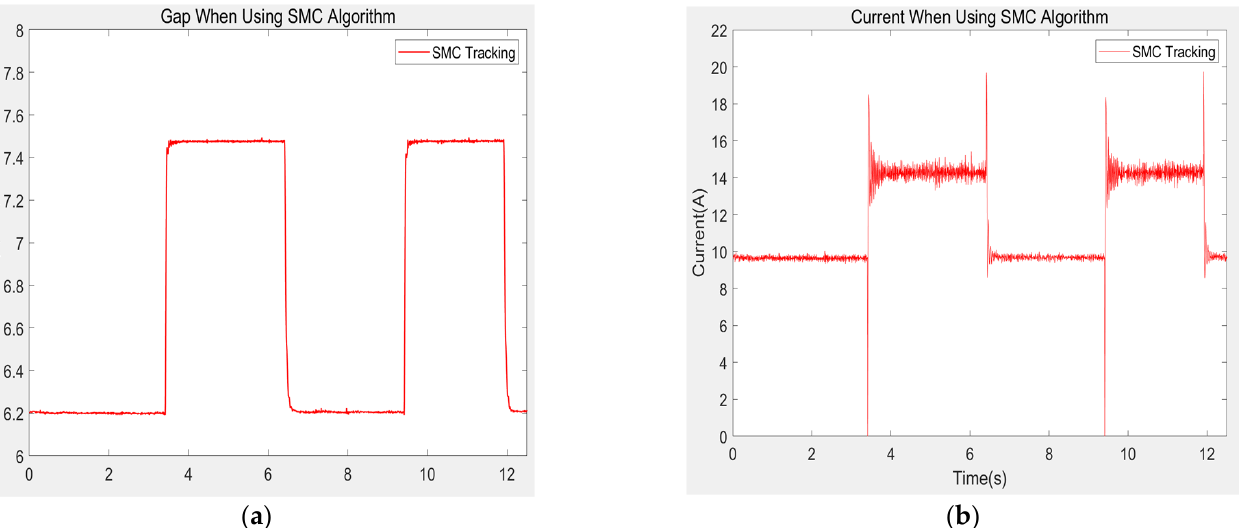
Figure 21. Gap and current value under SMC control algorithm: ( a ) Gap value; ( b ) current value.